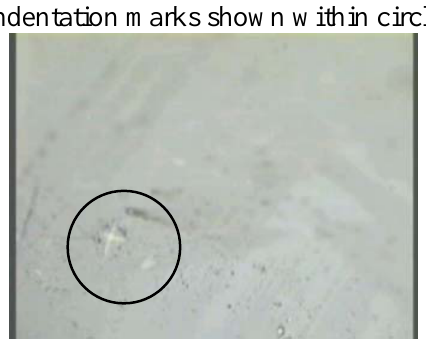
Figure 10. Hardness test using MST (CSEM) micro indentation tester. (indentation marks shown within circle)